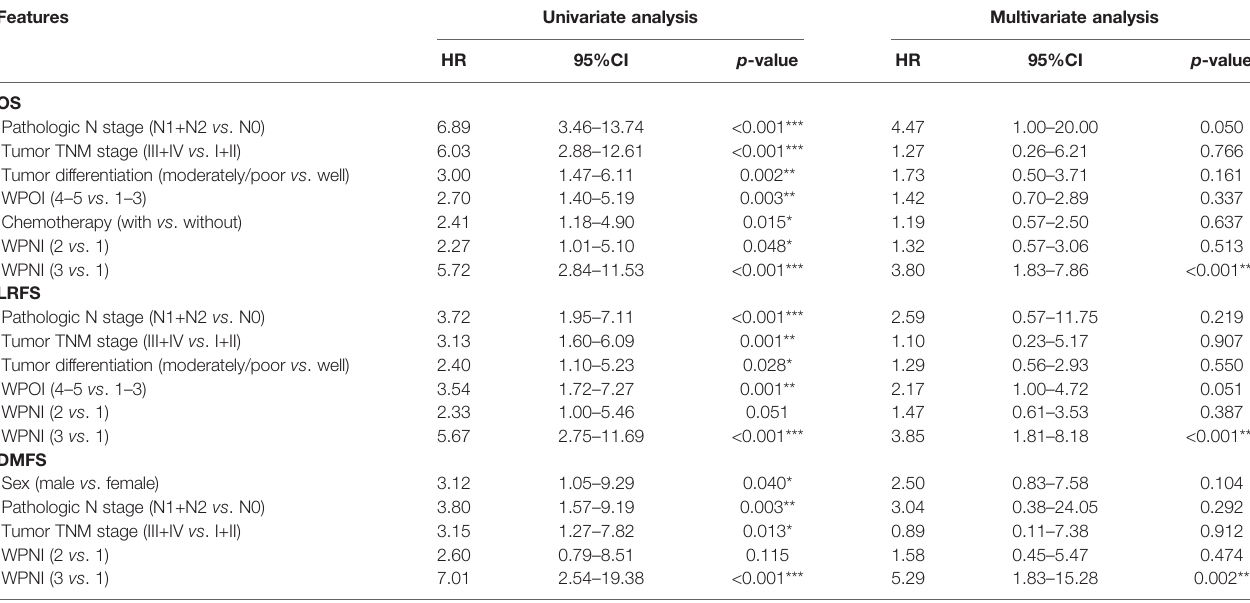
TABLE 3 | Univariate and multivariate analysis for OS, LRFS, and